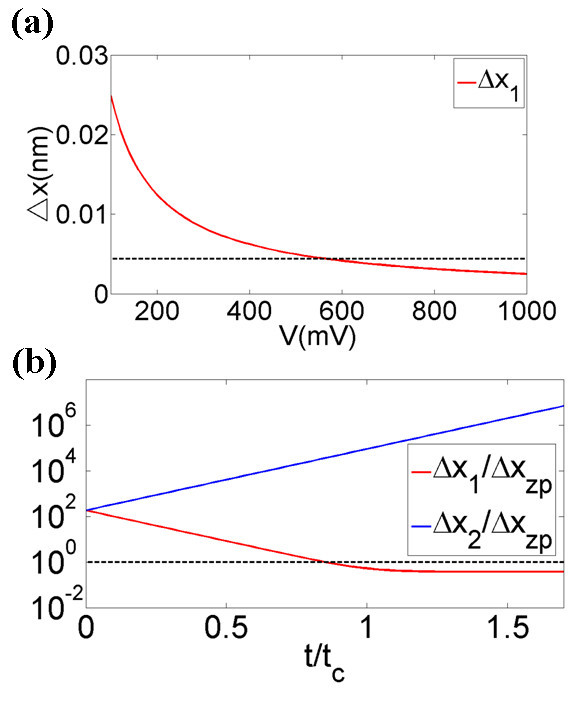
(a) ΔX1 versus applied voltages of graphene film and the dashed reference line is ΔX = Δxzp. (b) Time dependences of ΔX1 and ΔX2, which are expressed in units of Δxzp, where time is in units of tct, θ = 0, and the dashed reference line is ΔX = Δxzp. L = 1.1 μm, W = 0.2 μm, d = 0.1 μm, T = 5 K, Q = 14000, and V = 2.5V.